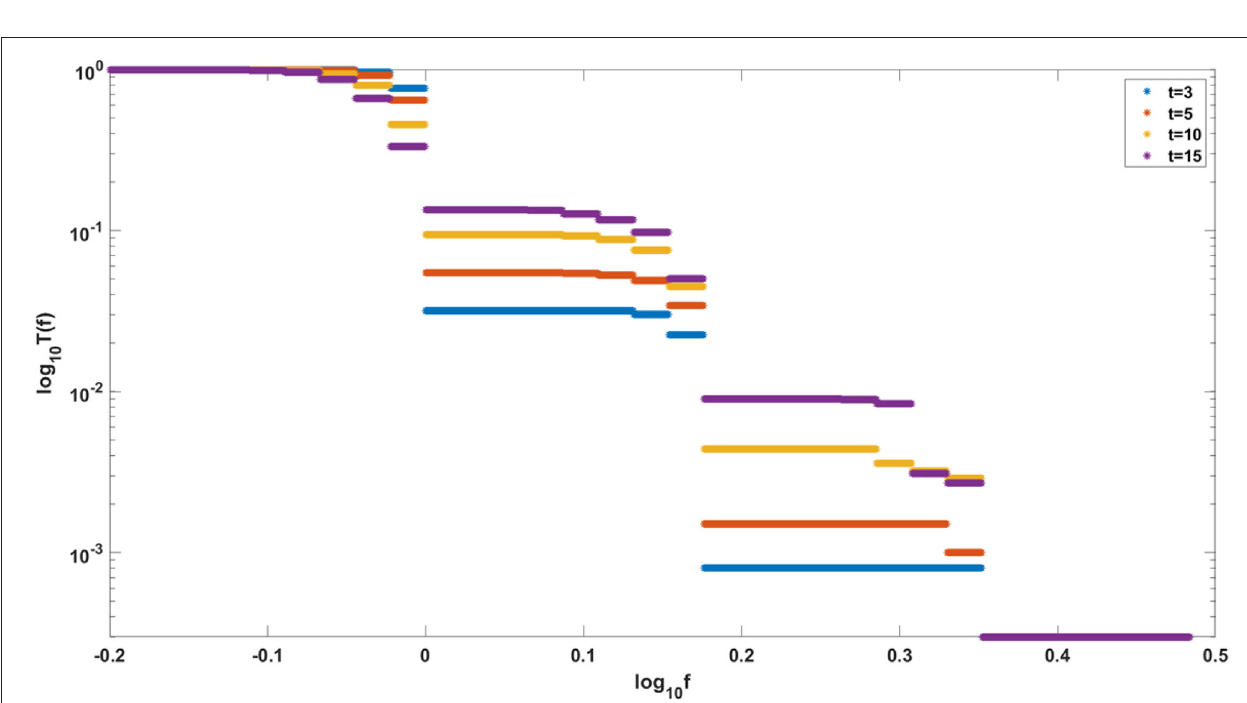
FIGURE 14 | Comparison of semi-logarithmic cumulative tails of the SFS obtained for experimental data from patient G30 to simulations with Model A with varying µ . Average from 100 simulations on 200 cells at time t = 100. s = 0.5, d = 0.0001, p = 0.01, N = 200.